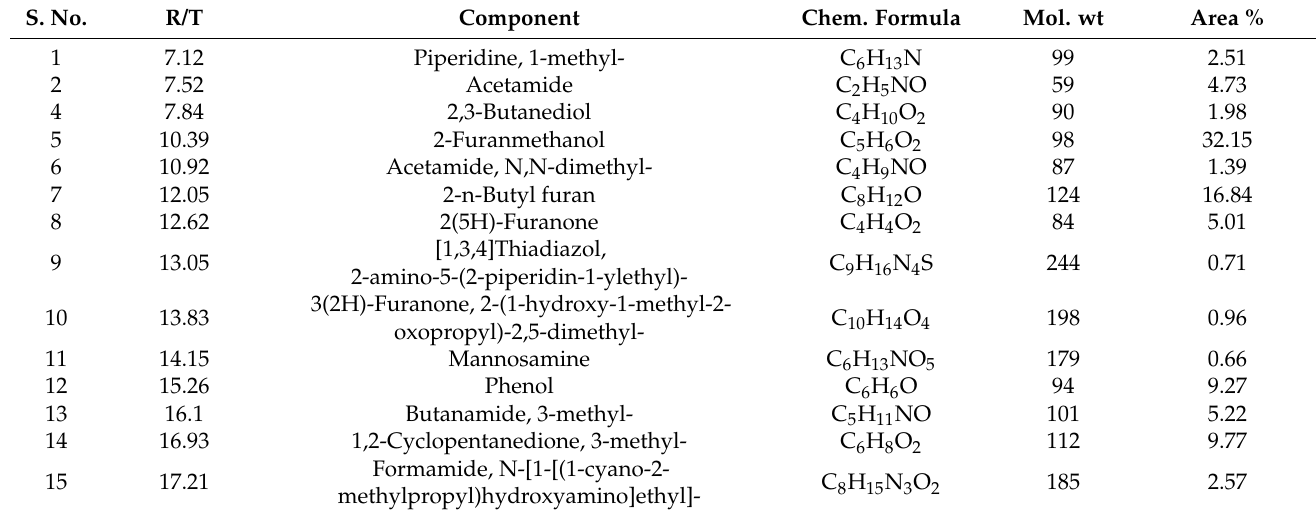
Table 3. Composition of oil obtained from karanja seed press cake with